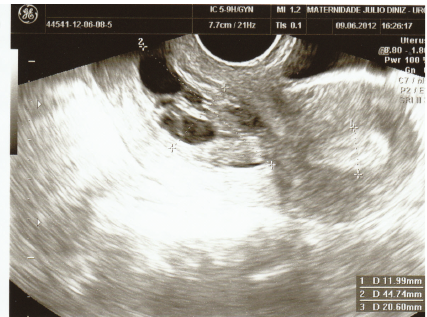
Figure 3: Follow-up endovaginal ultrasound, 3 months later: linear endocervical